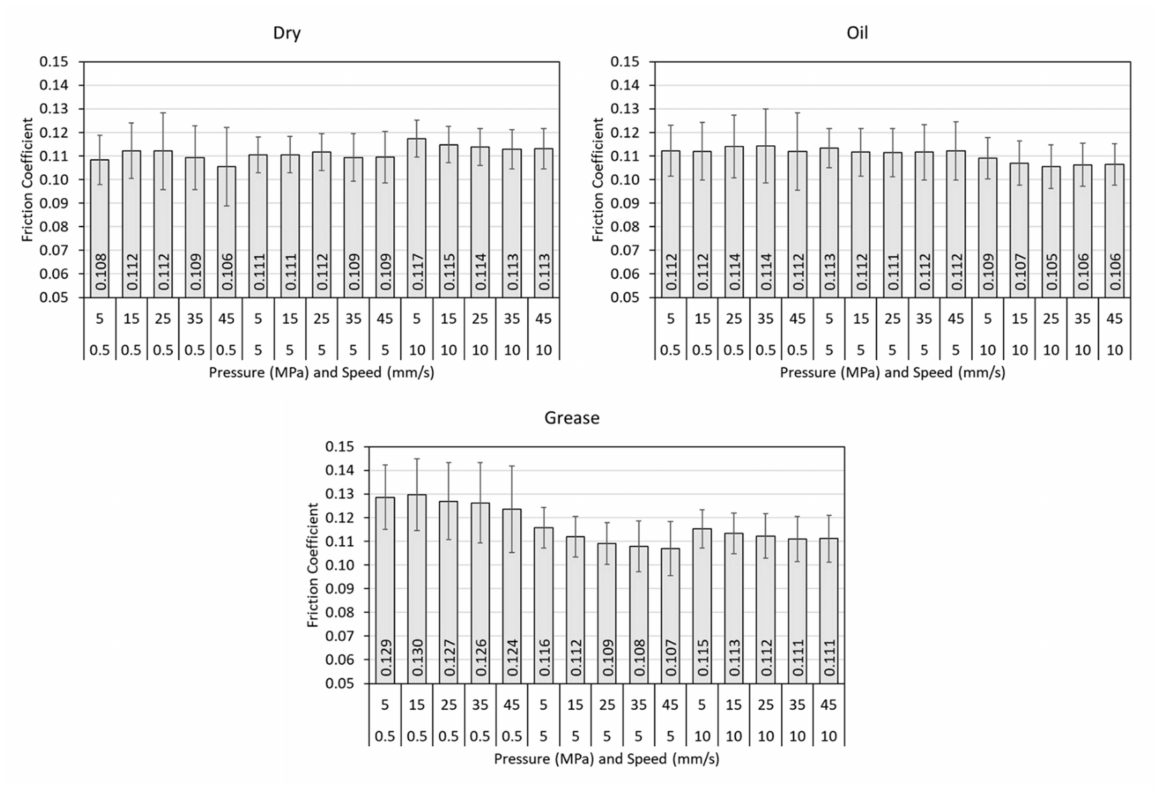
Figure 3. Tribology test without lubrication and with oil and grease at room temperature.